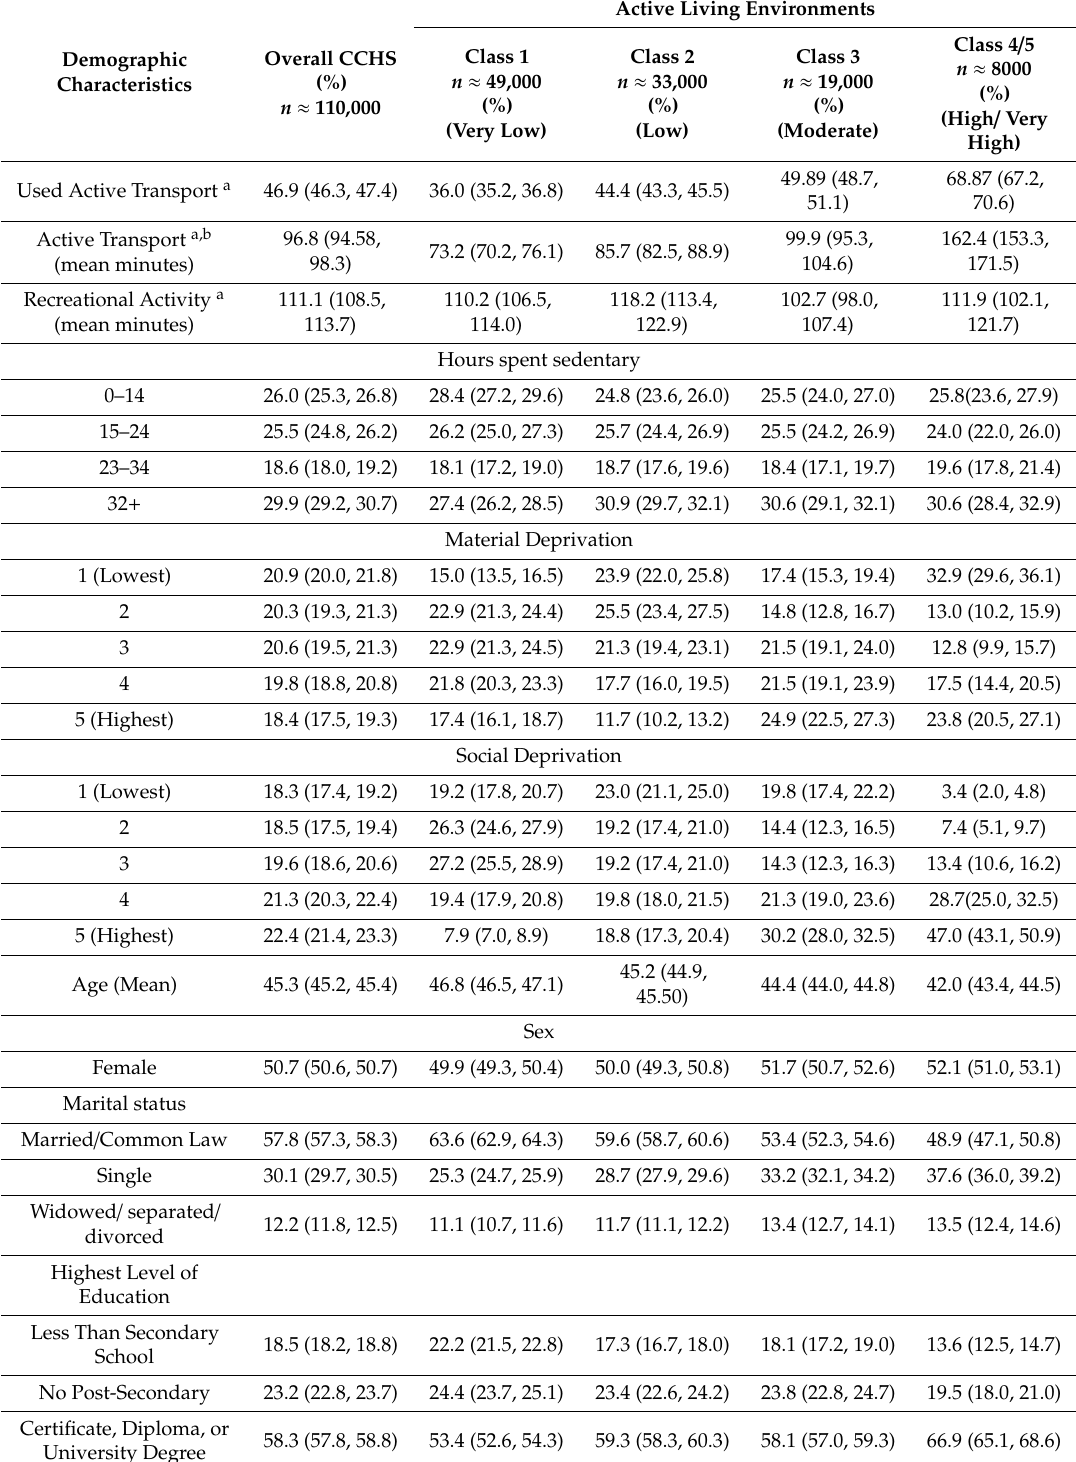
Table 1. Proportion of demographic characteristics overall and by the active living environment class with 95% confidence